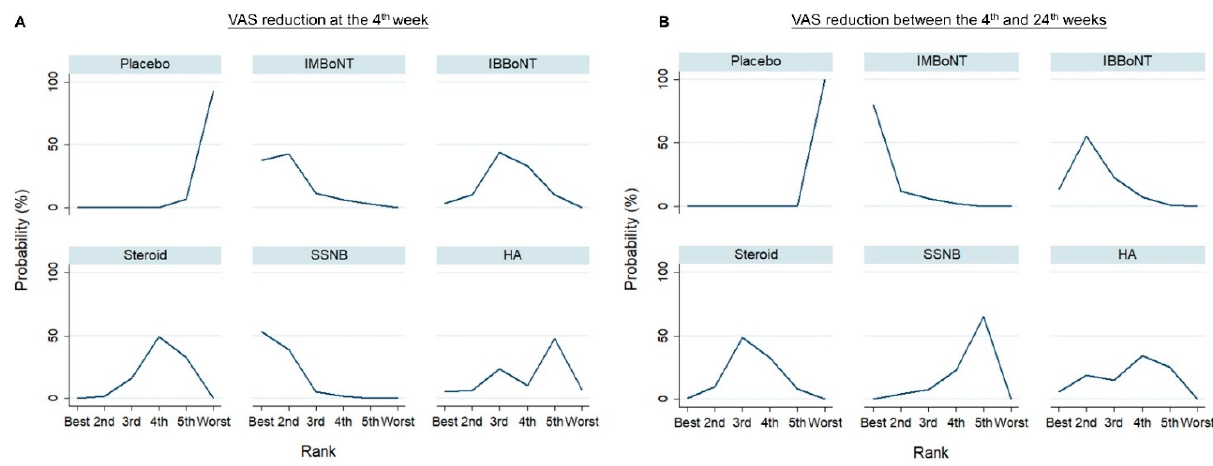
Figure 5. Ranking probabilities for different injection therapies in terms of VAS reduction ( A ) at the 4th week and ( B )